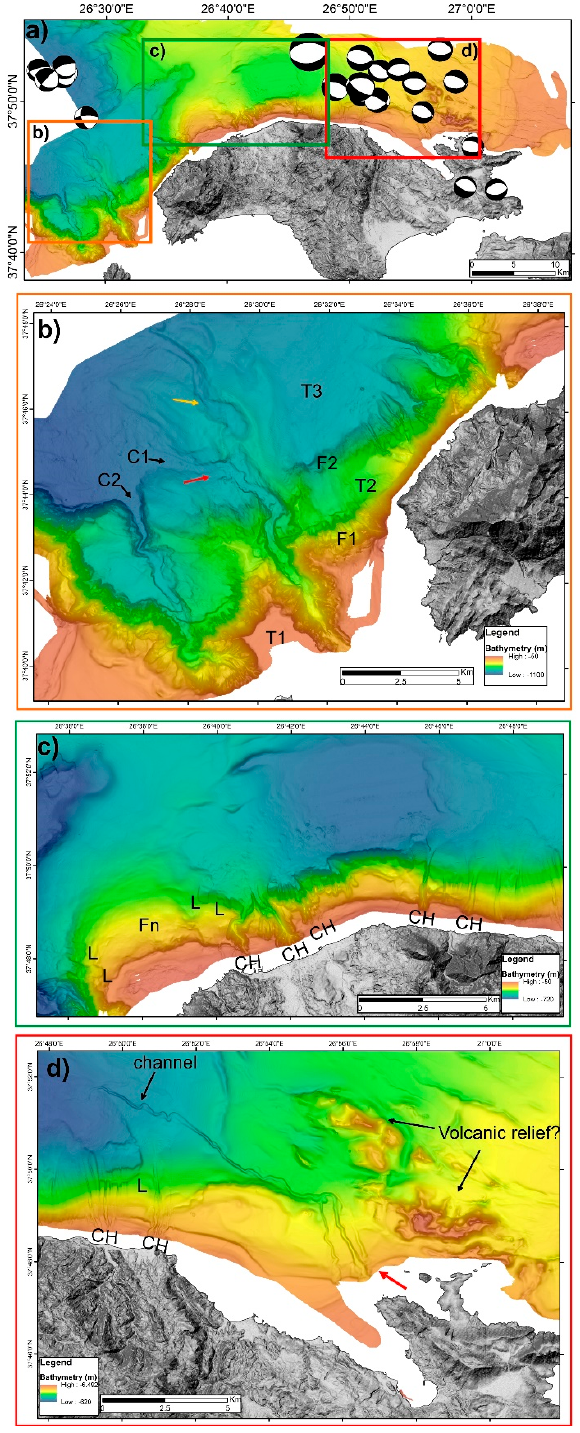
Figure 6. Detailed bathymetric maps of the northern marginal zone of Samos Island. ( a ) The fault plane solutions of the aftershock sequence 30 October 2020 offshore Samos Isand (from http://www.geophysics.geol.uoa.gr/stations/gmaps3/gmapv3_significant.php?mapmode=epic&lng=el&year=0 (accessed on 20 February 2021), as shown in Table S1) The three frames corre- spond to the detailed bathymetric maps, ( b ) SE Ikaria Basin, ( c ) W Samos Basin and ( d ) E Samos Basin. C: Canyon, CH: Canyon Head, Fn: Fan, L: Landslide, T: Terrace, F1, F2 faults. The colored arrows indicate special features explained in the